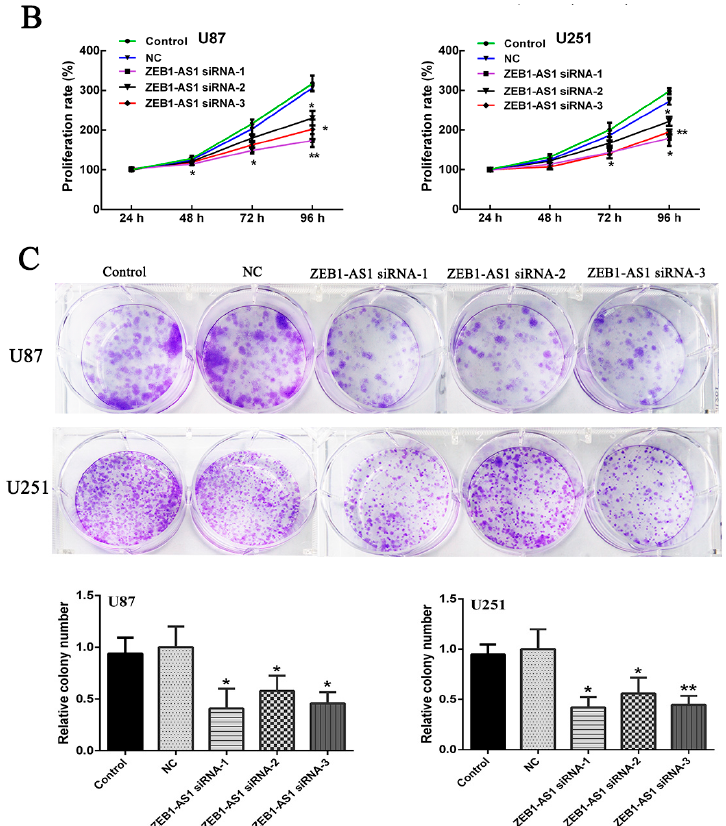
Figure 2. Knockdown of lncRNA ZEB1-AS1 inhibited the proliferation of glioma cell lines. ( A ) Silence of lncRNA ZEB1-AS1 expression in glioma cell lines by ZEB1-AS1-specific siRNAs; ( B ) CellTiter 96 aqueous one solution reagent (MTS) assay indicated that all of the three ZEB1-AS1 siRNAs could significantly suppress the proliferation abilities of U87 and U251 cells compared with negative control (NC) groups at 96 h; ( C ) Colony formation assay revealed that the silencing of ZEB1-AS1 greatly reduced the number of colonies of the U87 and U251 cells in comparison with the NC groups. * p < 0.05, ** p < 0.01, *** p < 0.001.